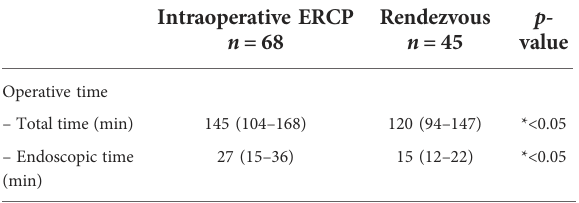
TABLE 2 Relationship between intraoperative data of intraoperative ERCP and rendezvous